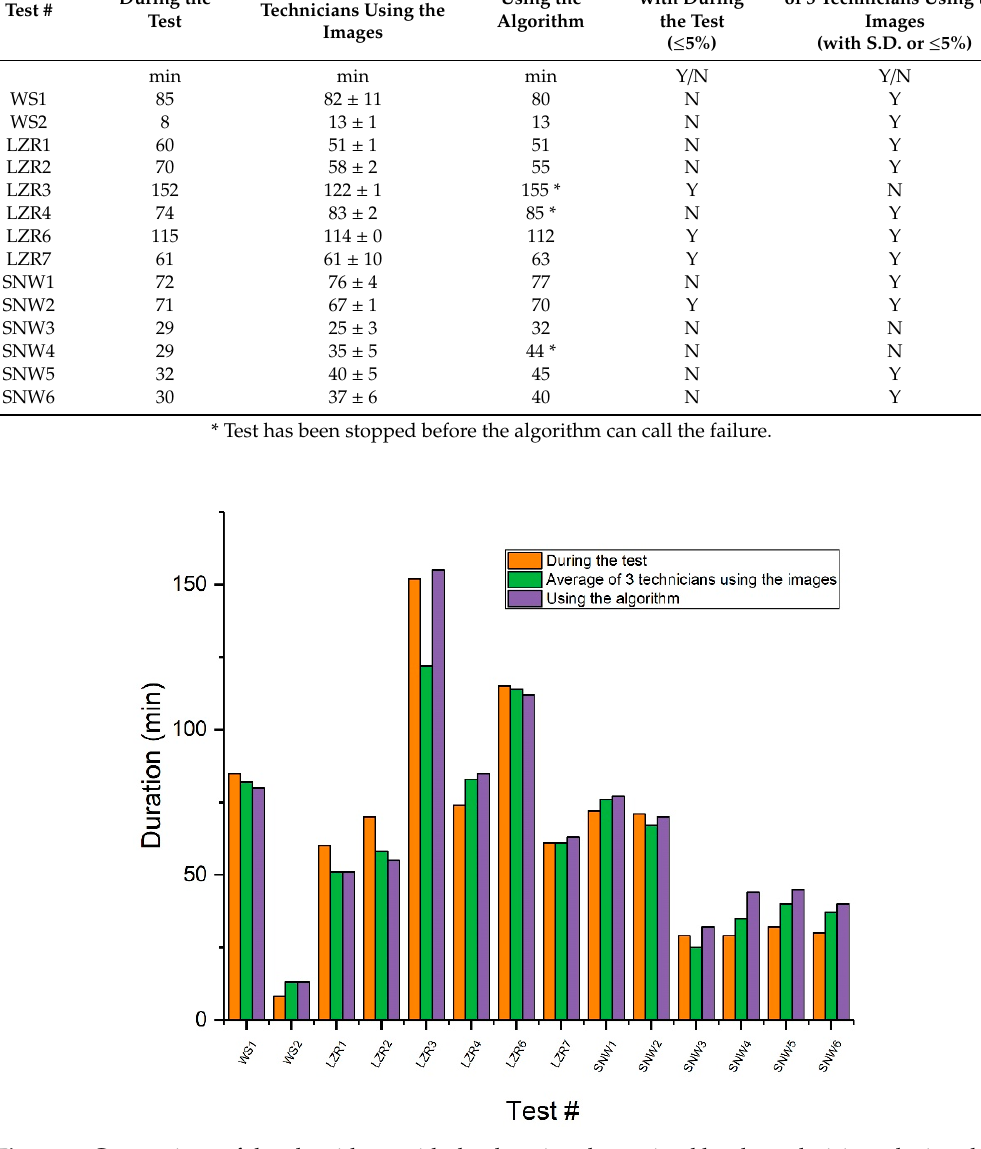
Figure 6. Comparison of the algorithms with the duration determined by the technicians during the test and using the same photos as the algorithms.